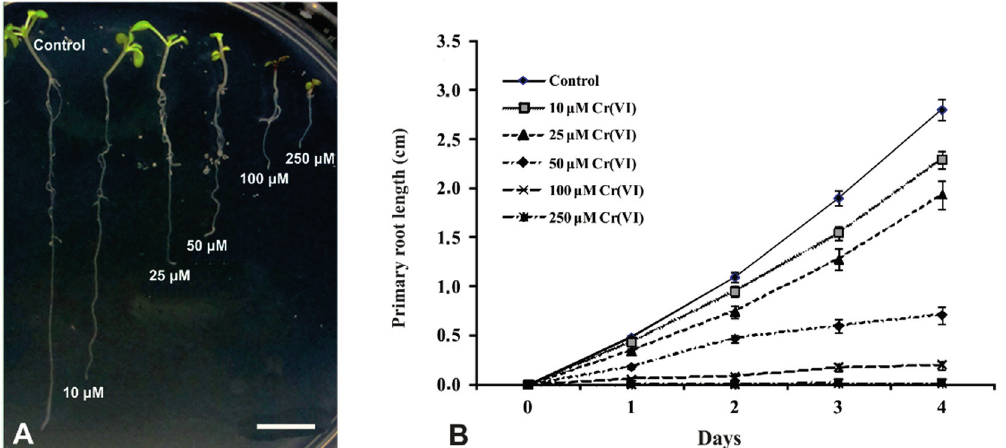
Figure 1. ( A ) Representative seedlings of Arabidopsis thaliana , first germinated in water for 4 days and then exposed for another 4 days to water (control) and increasing concentrations of Cr(VI). Note the decreasing size of the plantlets upon increasing Cr(VI) concentration; ( B ) Difference of primary root lengthening of 4-day-old pre-germinated seedlings of A. thaliana (day zero) exposed to water (control) and 10, 25, 50, 100 and 250 μ M Cr(VI) solutions. Each point represents the average ± standard error of a sample size n = 30. Scale bar: 1 cm. When different optical sections or different magnifications of the same specimen are used, they are identified with the same letter and numbered consecutively.